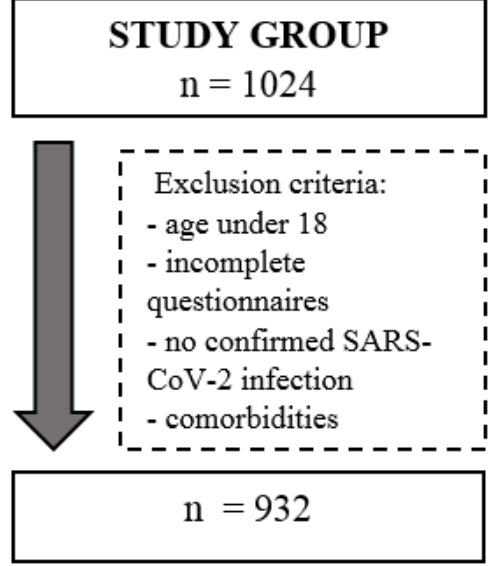
Figure 1. Exclusion criteria.